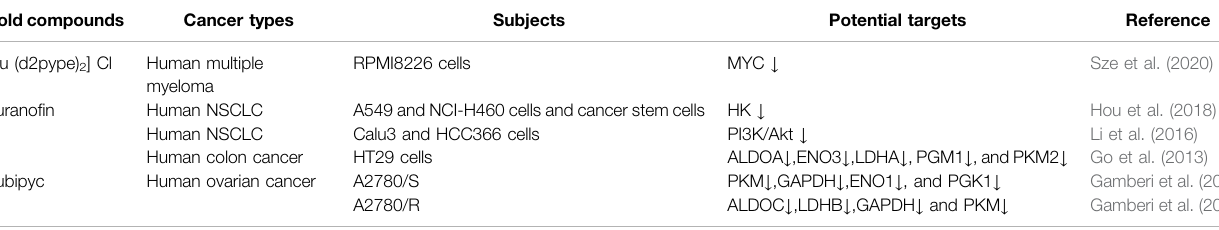
TABLE 1 | Effects of gold compounds on aerobic glycolysis metabolism in tumor cells.